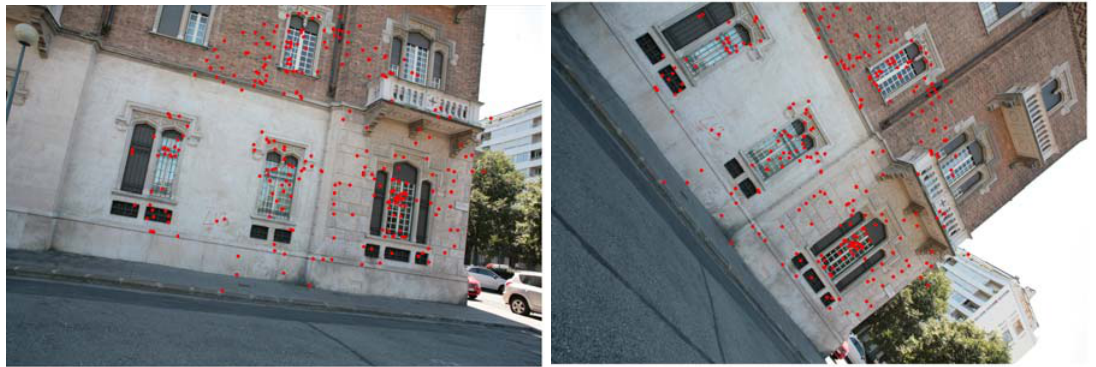
Figure 4. The Duca house test. The image correspondences automatically matched with SIFT (344 points, Th_eu = 2, L = 10).